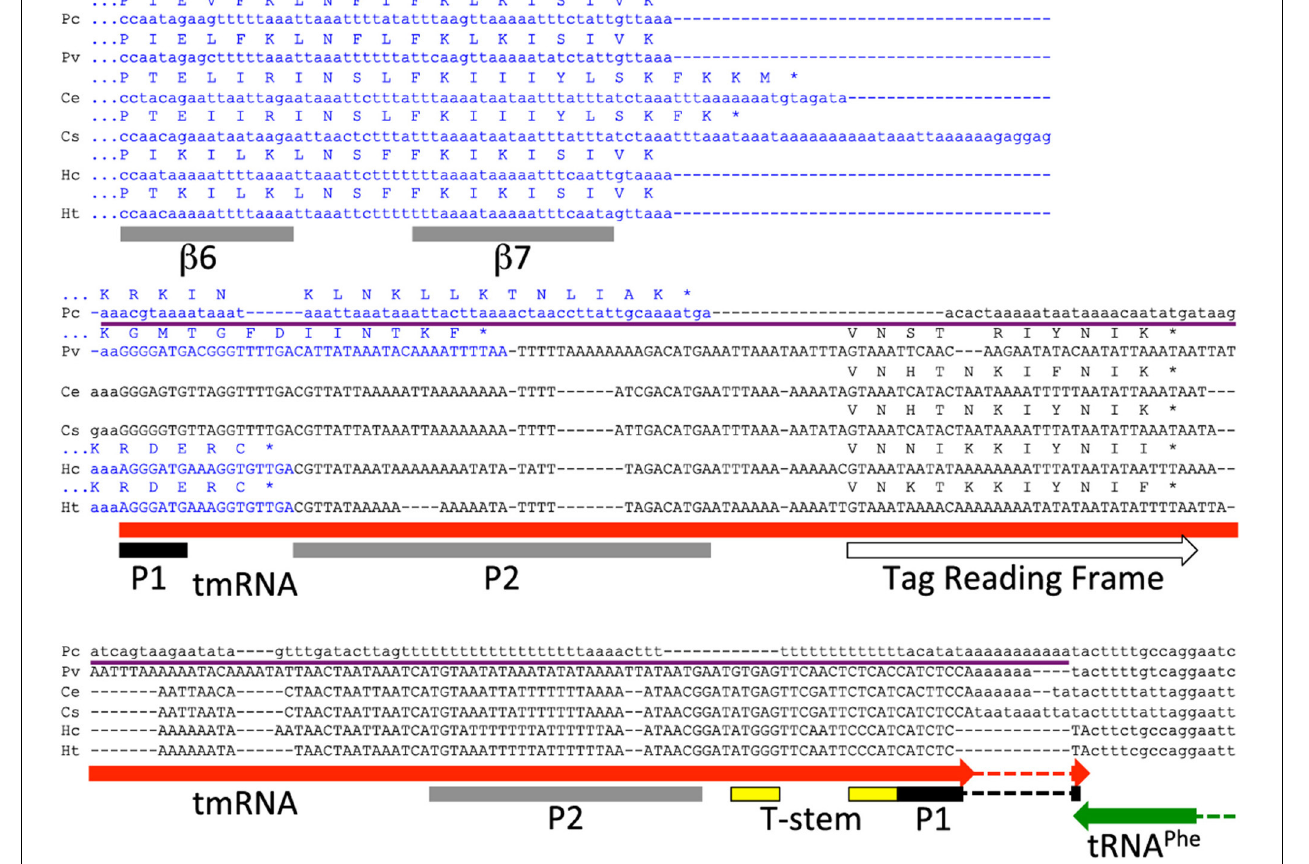
FIGURE 2 | Carsonella smpB-ssrA : pseudogenization, neighbor gene overlap, and comparative detection of the tag reading frame. In strain PC, the three main ssrA conserved regions, at the 5 (cid:2) and 3 (cid:2) termini and at the tag reading frame, have all suffered so many nucleotide changes as to be unrecognizable, yet the region is largely still present. The smpB CDS (blue) extends into ssrA (expected to produce non-stop smpB mRNAs) or the ssrA pseudogene in four cases. In the HC/HT lineage, a small deletion has caused ssrA to overlap with its downstream and oppositely-oriented neighboring tRNA Phe gene changing the last tmRNA acceptor stem (P1) nucleotide from